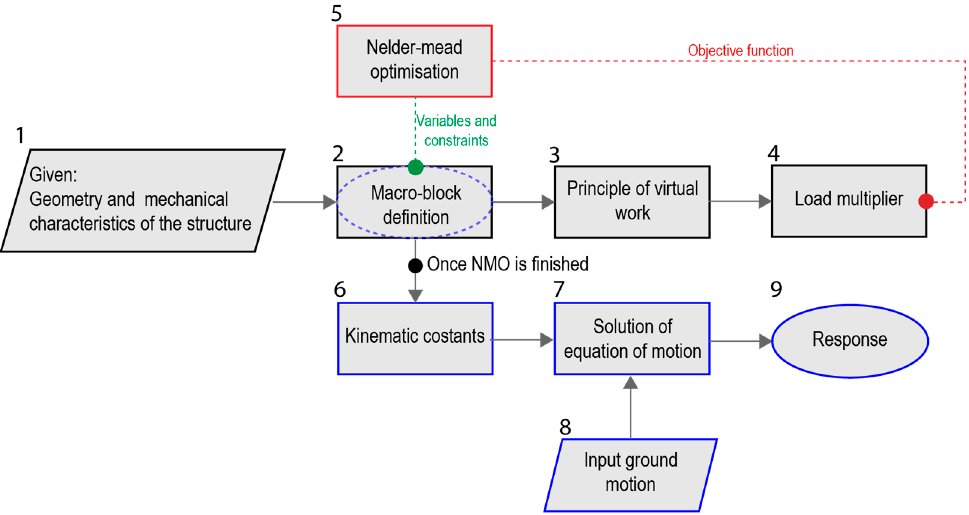
Figure 3. Flow chart representation of the proposed two-step analysis.